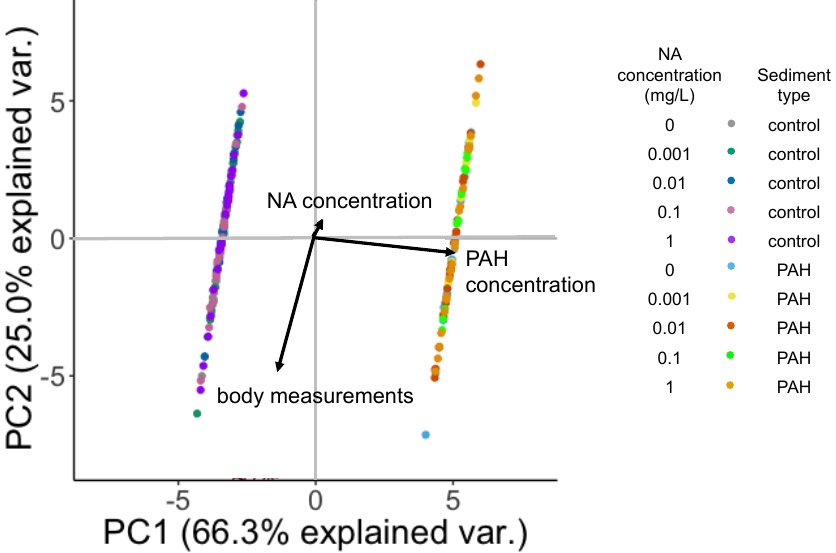
Figure 3. Principal components analysis (PCA) explaining 91.3% (66.3 + 25% EV) of the total variation in the body size measurements of Hexagenia nymphs exposed to an NA mixture gradient (0–1mg/L) and sediment with or without PAHs (see Table 2 for PAH concentrations).